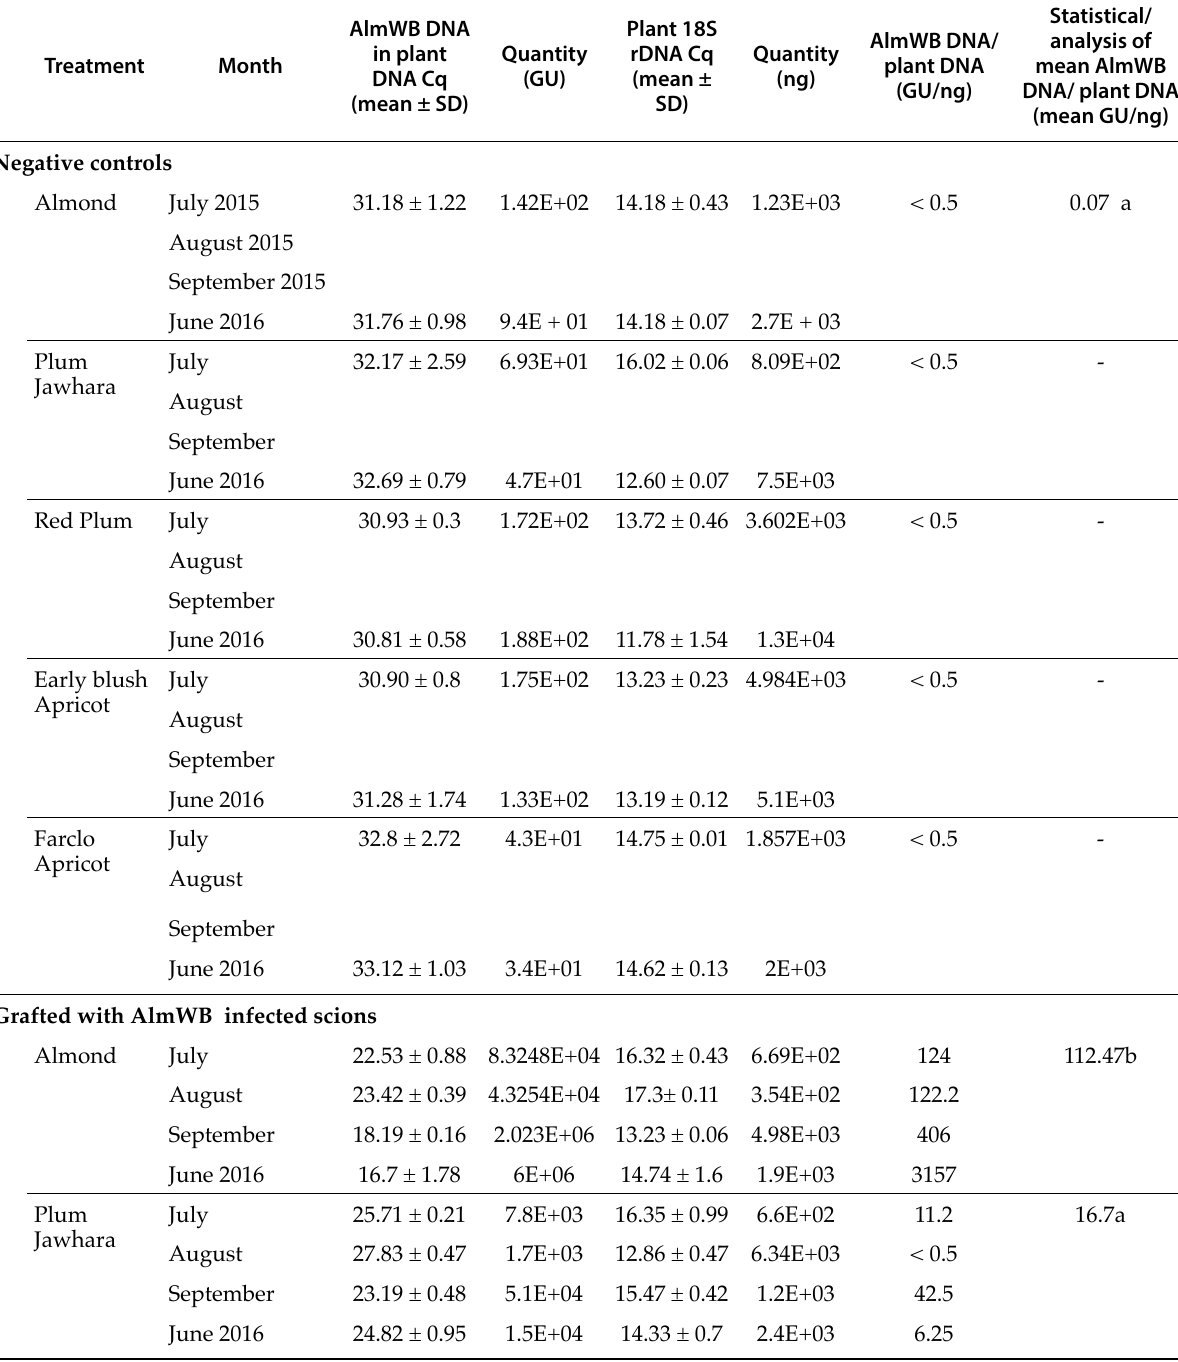
Table 3. Greenhouse experiment: detection and quantification of ‘ Ca. P. phoenicium’ in grafted and non-grafted (negative controls) stone fruit seedlings, during July, August and September 2015, and June 2016.